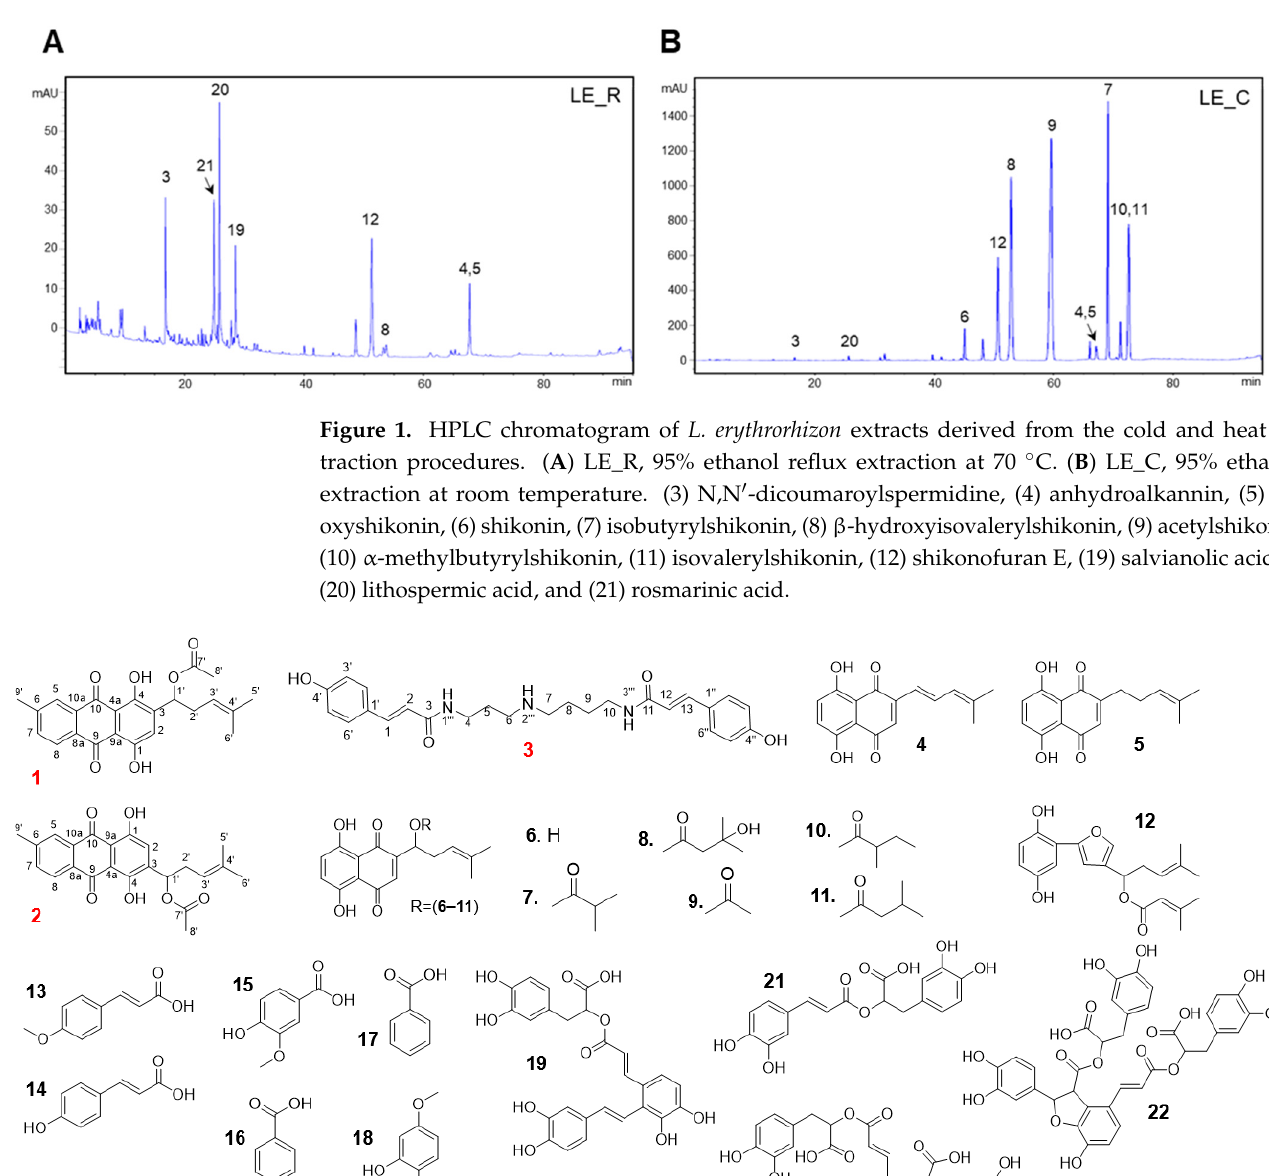
Figure 3. Key HBMC correlations exhibited by compounds 1 , 2 , and 3 . Table 1. 13 C and 1 H-NMR data for compound 1 and 2 (at 400 MHz for 1 H-NMR and 100 MHz for 13 C-NMR in CD 3 OD, ᵟ in ppm, J in Hz). Position